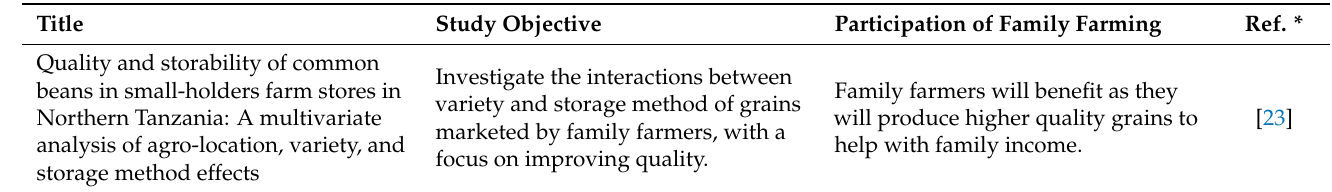
Table 1. Main information on articles that reported the direct role of family farming in the develop- ment of new food